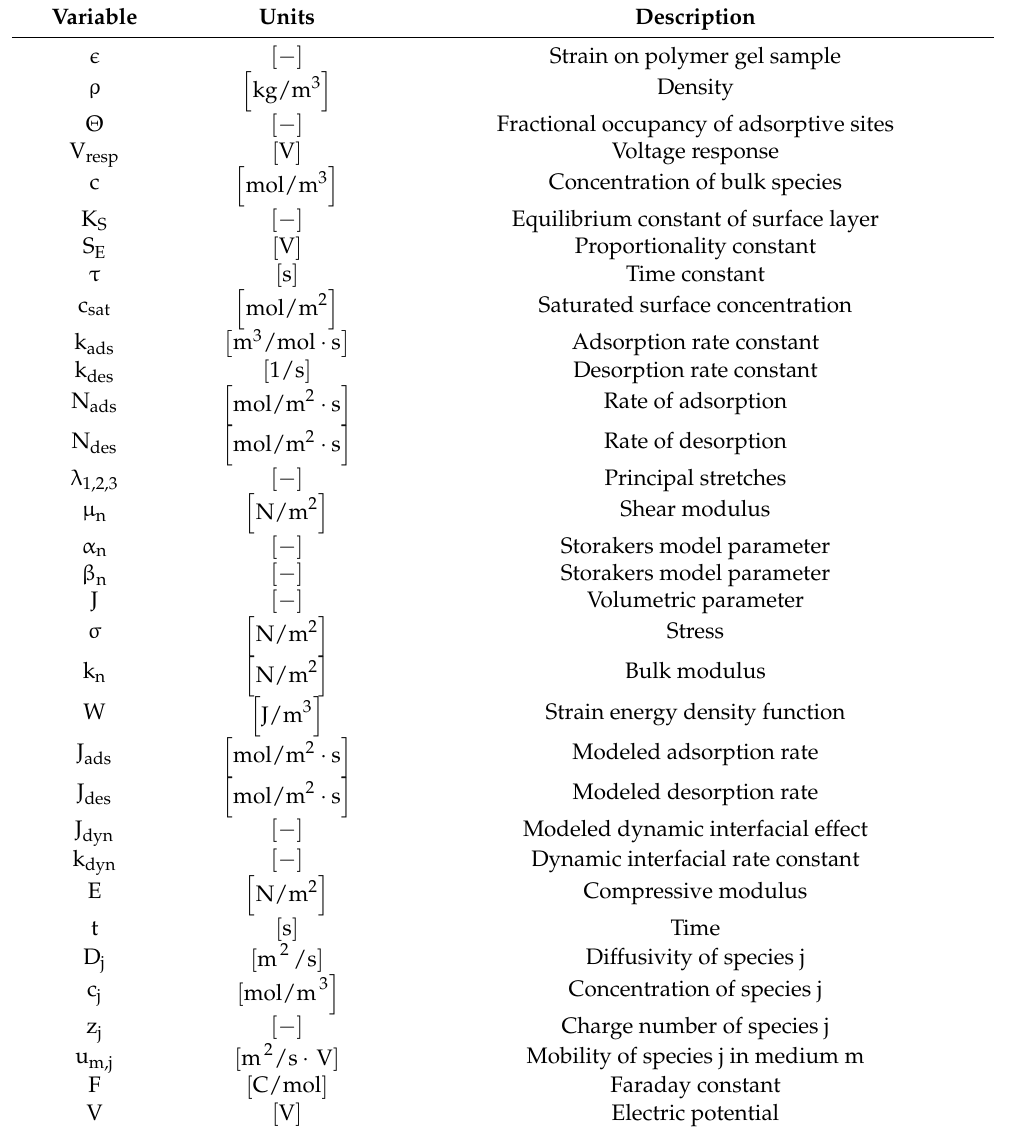
Table 1. Mathematical